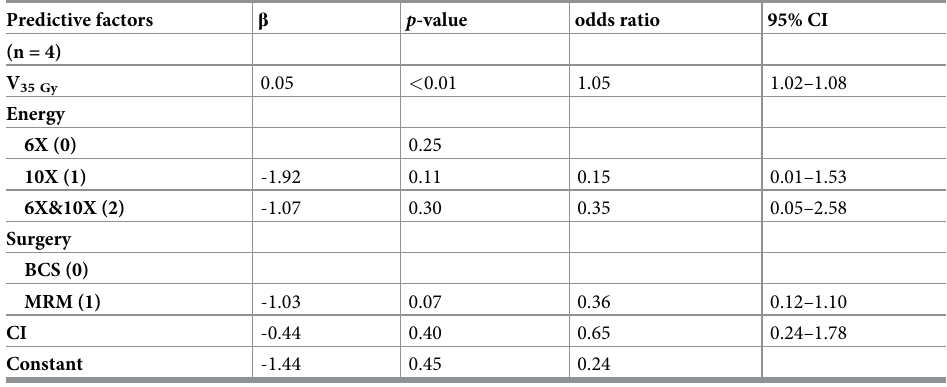
Abbreviations : RD: radiation dermatitis; CI: Conformity Index; V 35 was defined as skin volume received 35 Gy. Surgery: BCS: patients with breast conserving surgery; MRM: patients with modified radical mastectomy; 95%